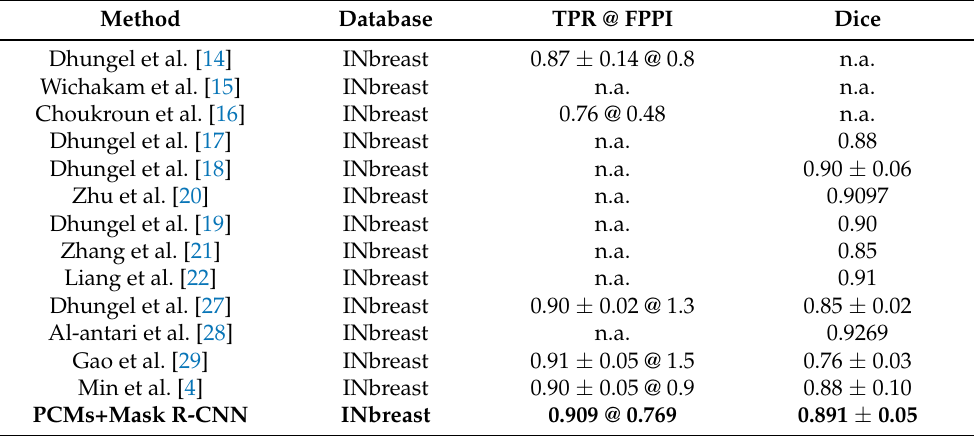
Table 2. Performance comparison between PCMs + Mask R-CNN and several other state-of-the- art methods. The PCMs + Mask R-CNN is marked in